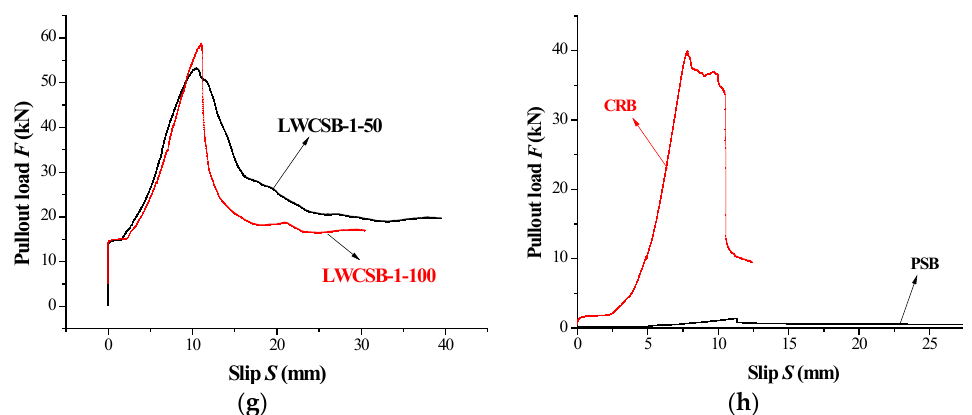
Figure 5. The F–S curves of different specimens. ( a ) LWCSB-1, l a = 50 mm; ( b ) LWCSB-1, l a = 100 mm; ( c ) LWCSB-2, l a = 50 mm; ( d ) LWCSB-2, l a = 100 mm; ( e ) LWCSB-3, l a = 50 mm; ( f ) LWCSB-3, l a = 100 mm; ( g ) LWCSB-1, Φ 12; ( h ) LWCSB-2, CRB, PSB, Φ 16, l a = 100 mm.